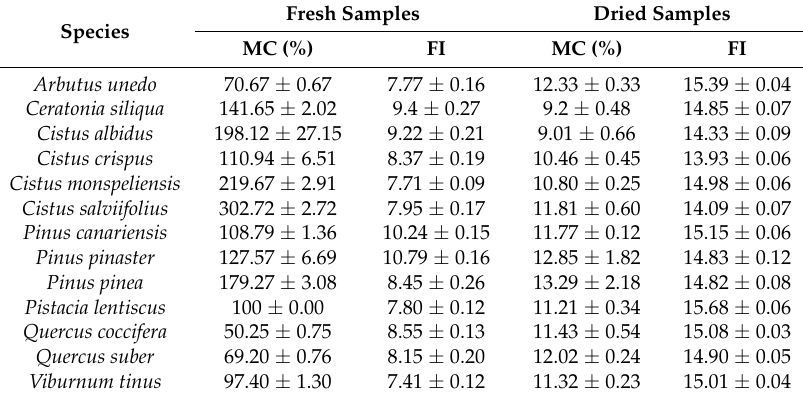
Table 4. Average values of the flammability indices calculated based on Equation (3) per species for fresh and dried samples and their respective average MC-values followed by standard errors.